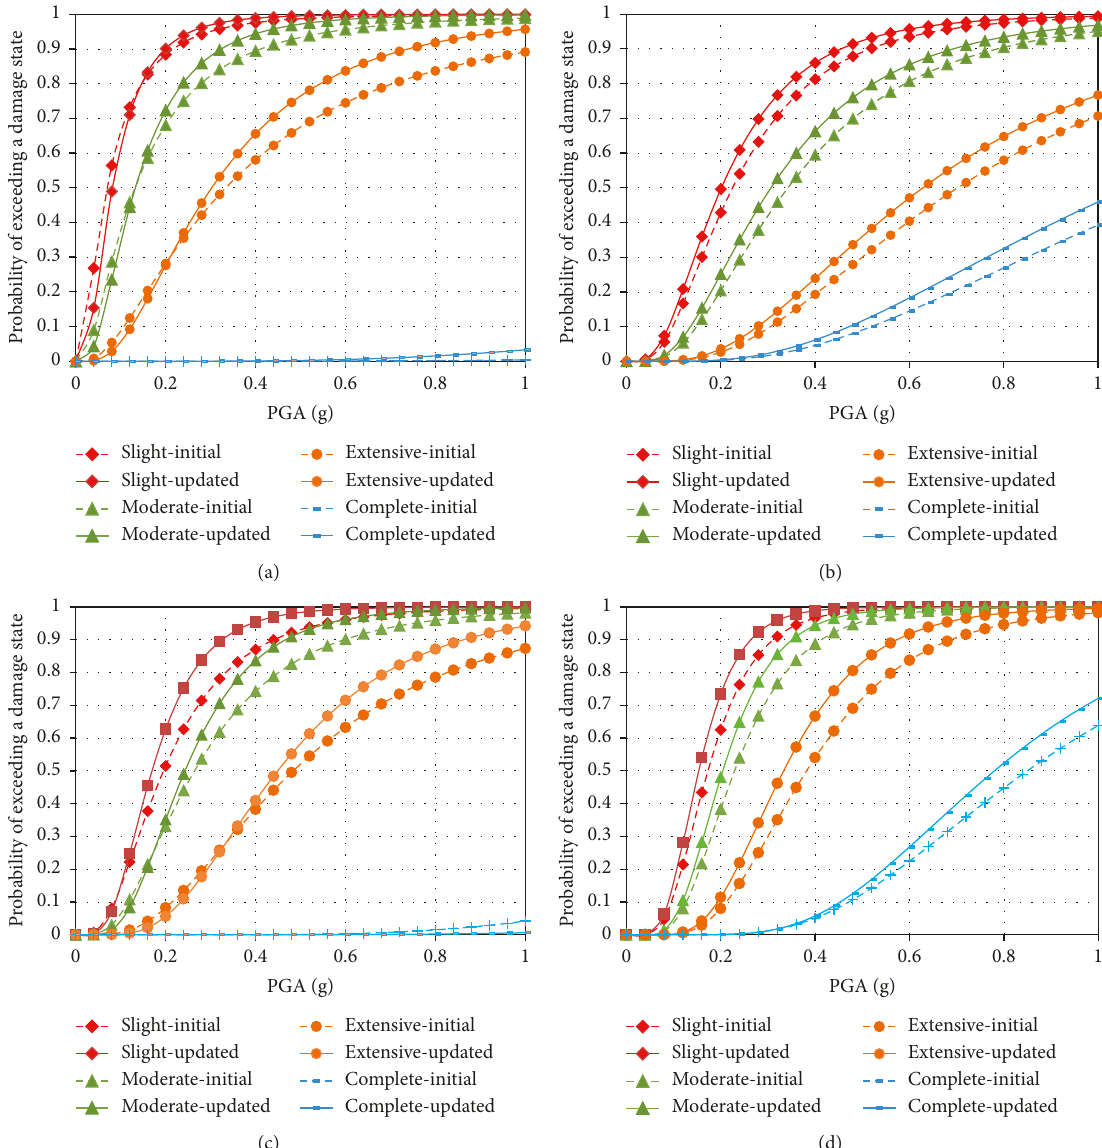
Figure 18: Fragility comparison between the initial model and the updated model. (a) Longitudinal fragility curves of bearing #10. (b) Transversal fragility curves of bearing #7. (c) Transversal fragility curves of bearing #11. (d) Transversal fragility curves of bearing